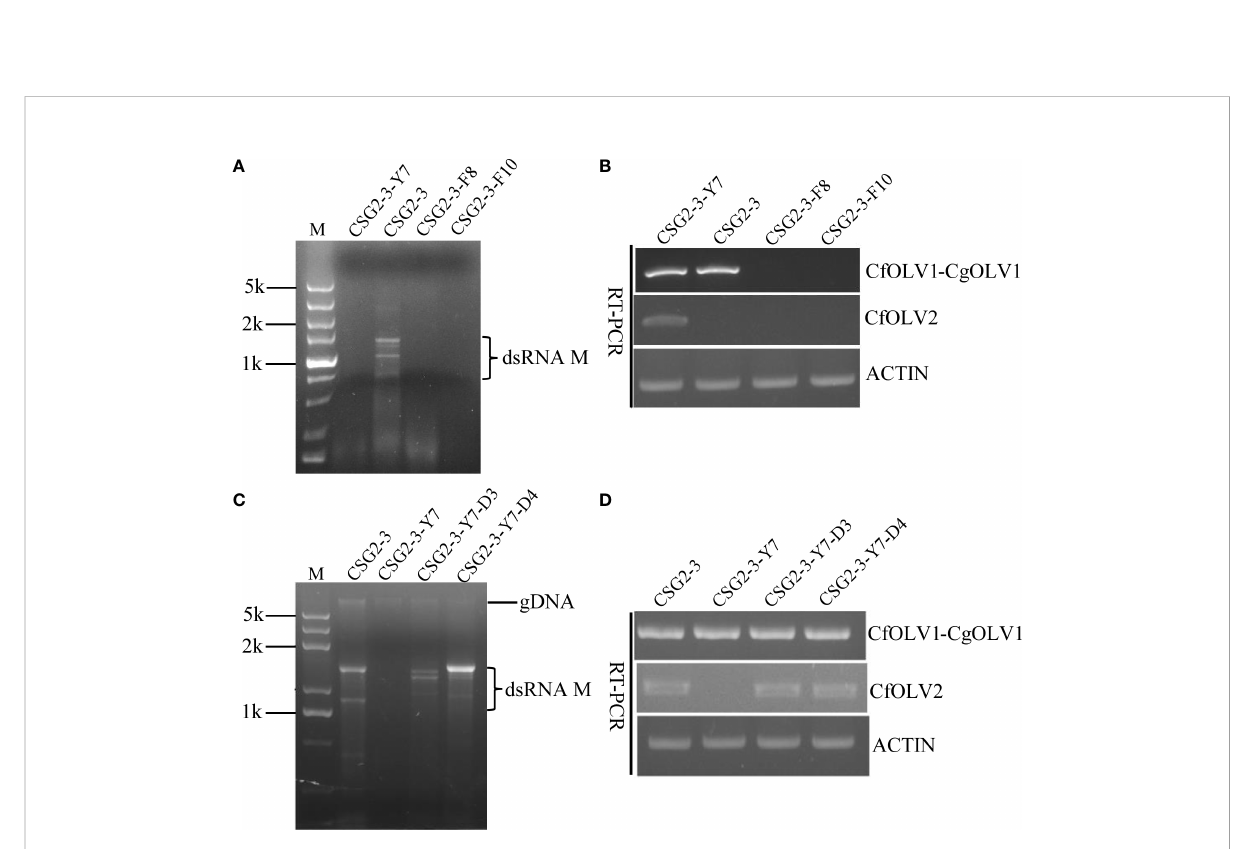
FIGURE 3 Agarose gel electrophoresis of dsRNA in C. fructicola and RT-PCR detection of CfOLV1-CgOLV1 and CfOLV2. (A, C) 1% agarose electrophoresis analysis of dsRNA extracted from the mycelia of CSG2-3, CSG2-3-Y7, CSG2-3-F8/F10, and CSG2-3-Y7-D3/D4. M=DL5000 DNA marker (TSINGKE, Changsha, China). (B, D) RT-PCR detection of CfOLV1-CgOLV1 and CfOLV2 in different isogenic